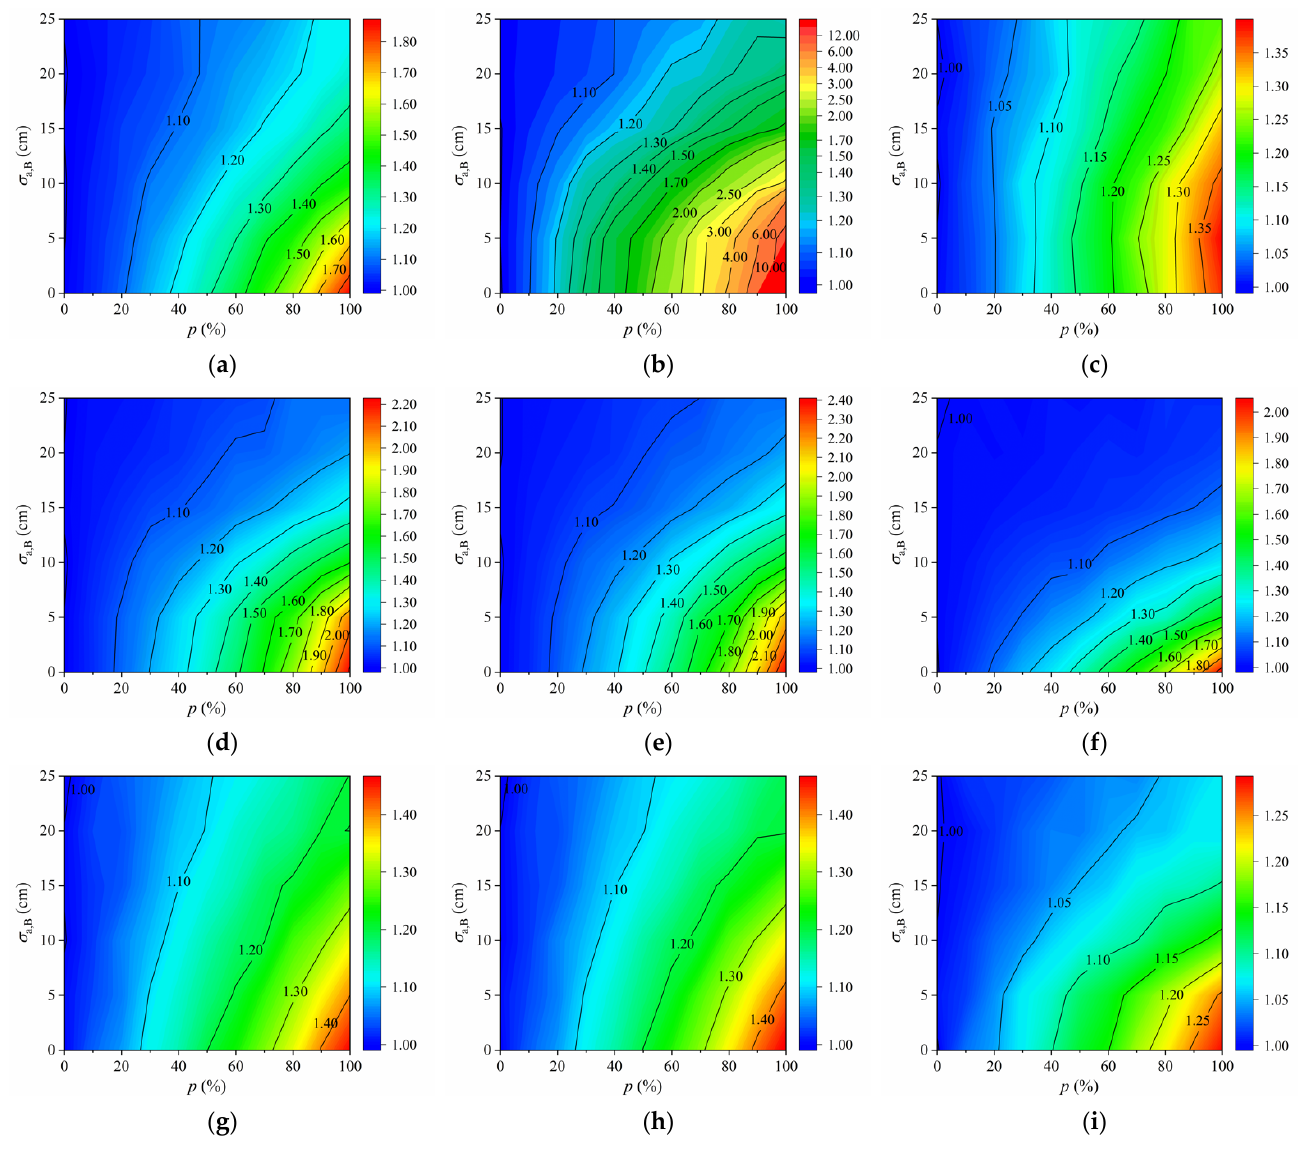
Figure 13. Y m / Y h of fatigue details under the scenario of Pattern 2: ( a ) D1 in COSD; ( b ) D2 in